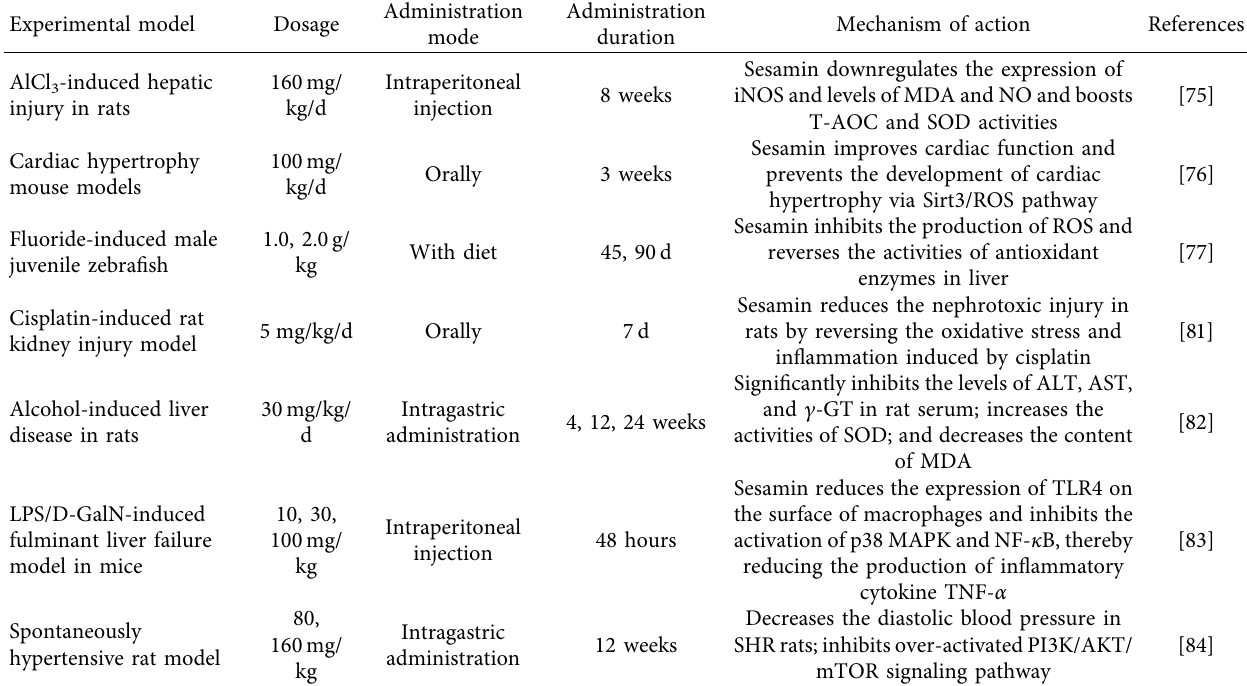
Table 4: Effects of sesamin on protection liver and